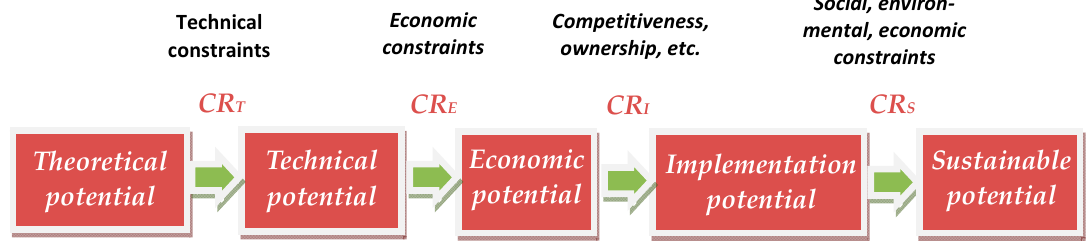
Figure 1. Flowchart and coefficients of reduction (CRs) for the assessment of pruning potentials.